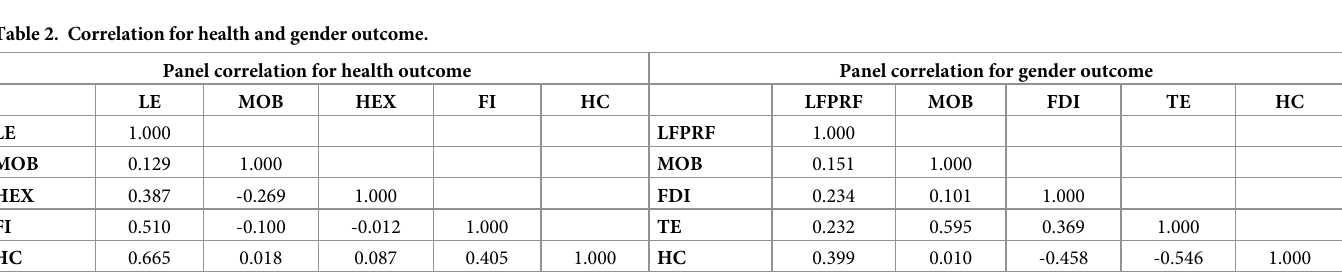
Table 2. Correlation for health and gender